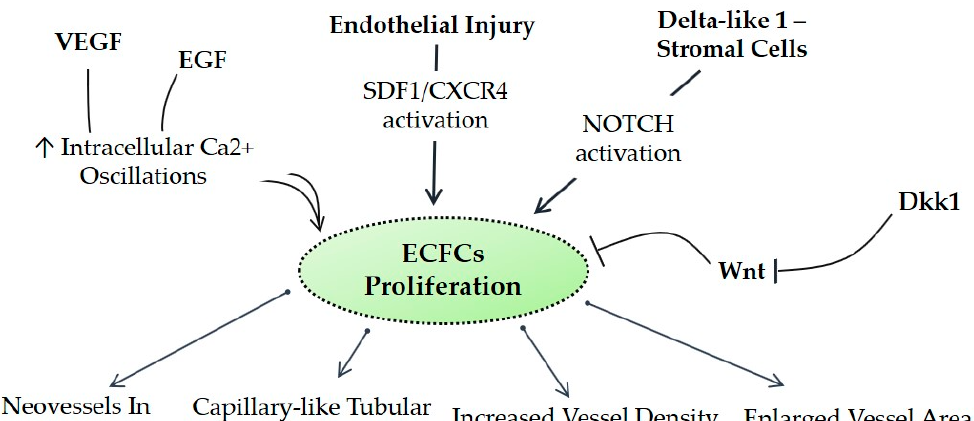
Figure 1. Postulated signaling pathways affecting endothelial progenitor cells (EPCs). CXCR4, C-X-C chemokine receptor type 4; Dkk1, dickkopf WNT signaling pathway inhibitor 1; ECFCs, endothelial colony-forming cells; EGF, epidermal growth factor; SDF-1, stromal cell-derived factor 1; VEGF, vascular endothelial growth factor; WNT, wingless-type mouse mammary tumor virus integration site